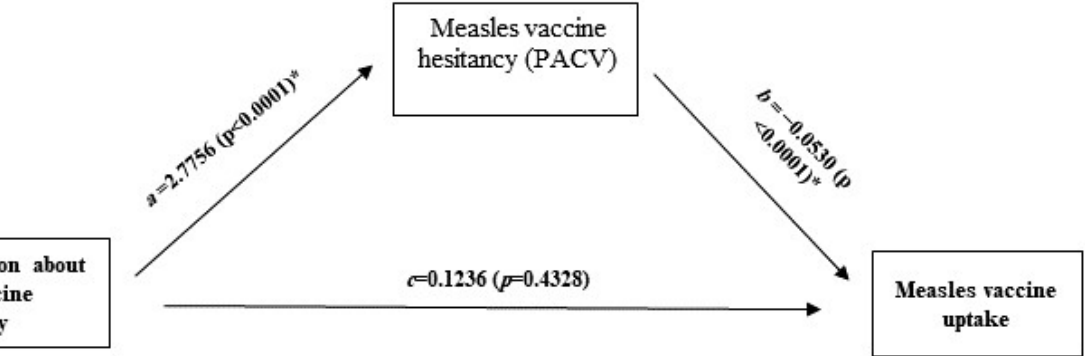
Figure 2. Mediation with path ( β ) coefficients and ( p -value) of Measles Vaccine Hesitancy (PACV) as the mediator in the relationship between parental perception about measles vaccine availability and measles vaccine uptake. * Statistically significant.